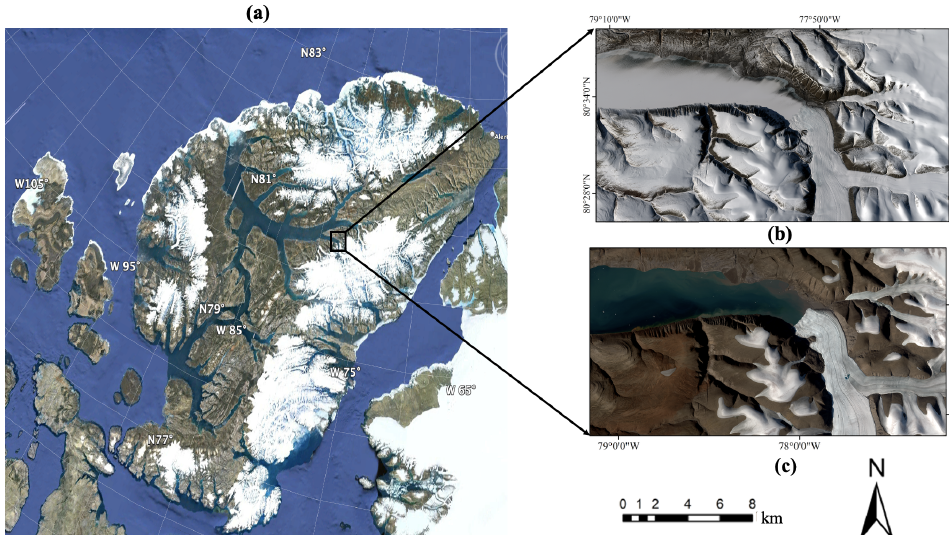
Figure 1. Study area. ( a ) Google Earth image © of the study area that includes Ellesmere Island in the Canadian state of Nunavut. The black square indicates the ice front area of the d’Iberville glacier under investigation. Sentinel-2 true-colour optical images collected over the ice front of the d’Iberville glacier on ( b ) 26 May 2021 and ( c ) 26 July